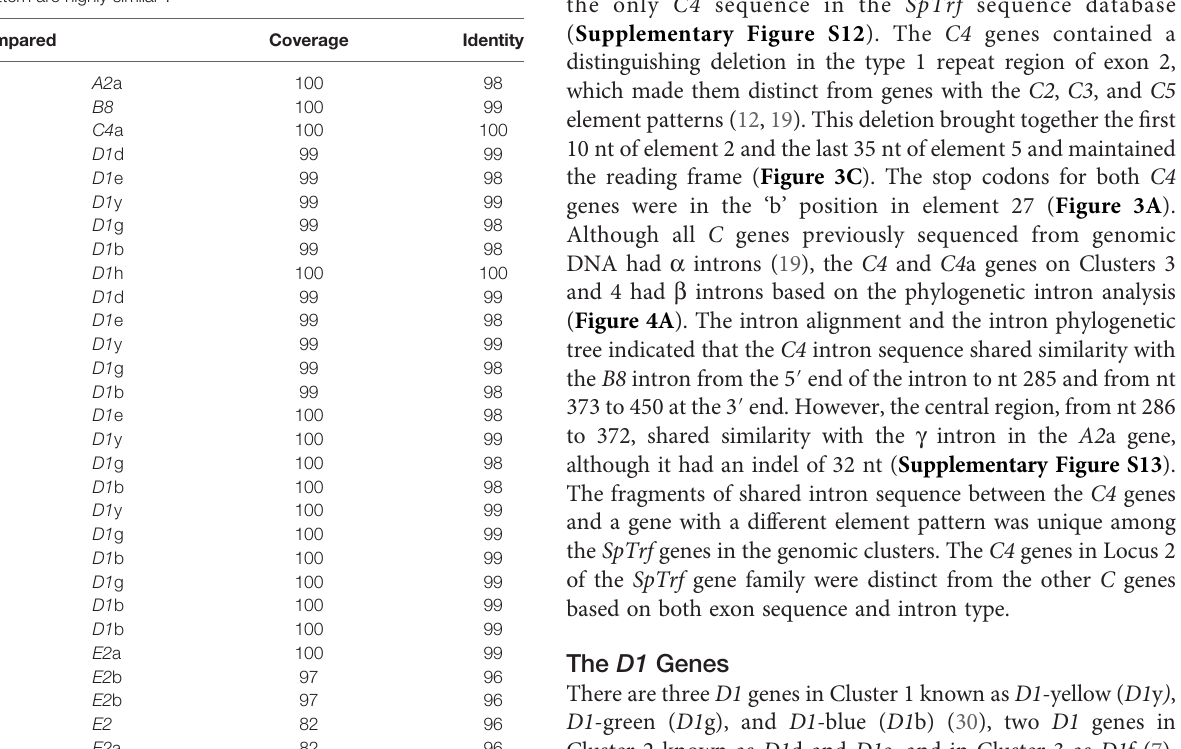
TABLE 3 | Percent identity and coverage of the SpTrf genes of the same element pattern are highly